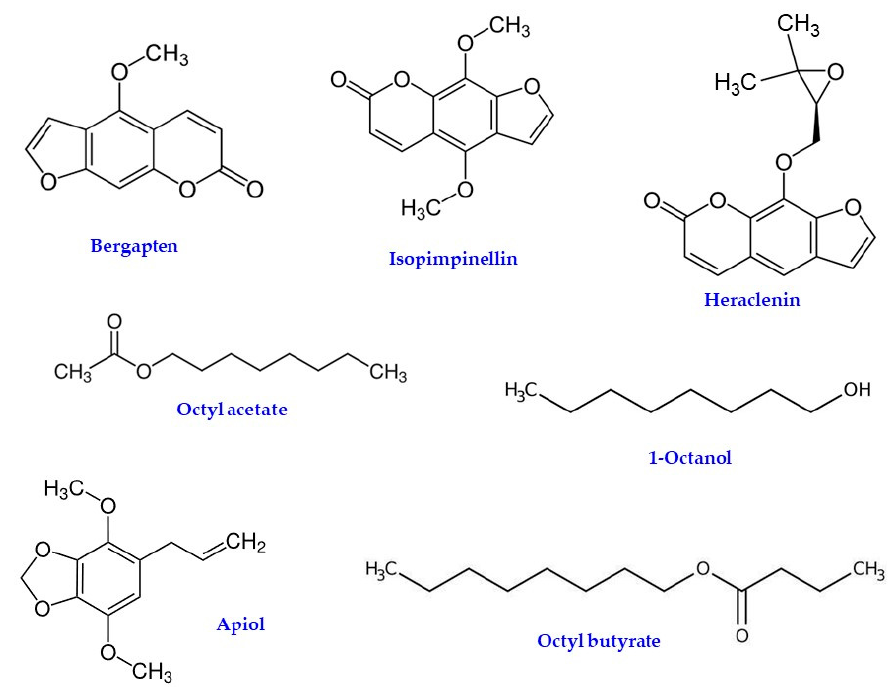
Figure 7. Chemical structure of some furocoumarins (Bergapten, Isopimpinellin, and Heraclenin) and volatile compounds (Octyl acetate, 1-Octanol, Apiol, and Octyl butyrate) found in H. sphon- dylium